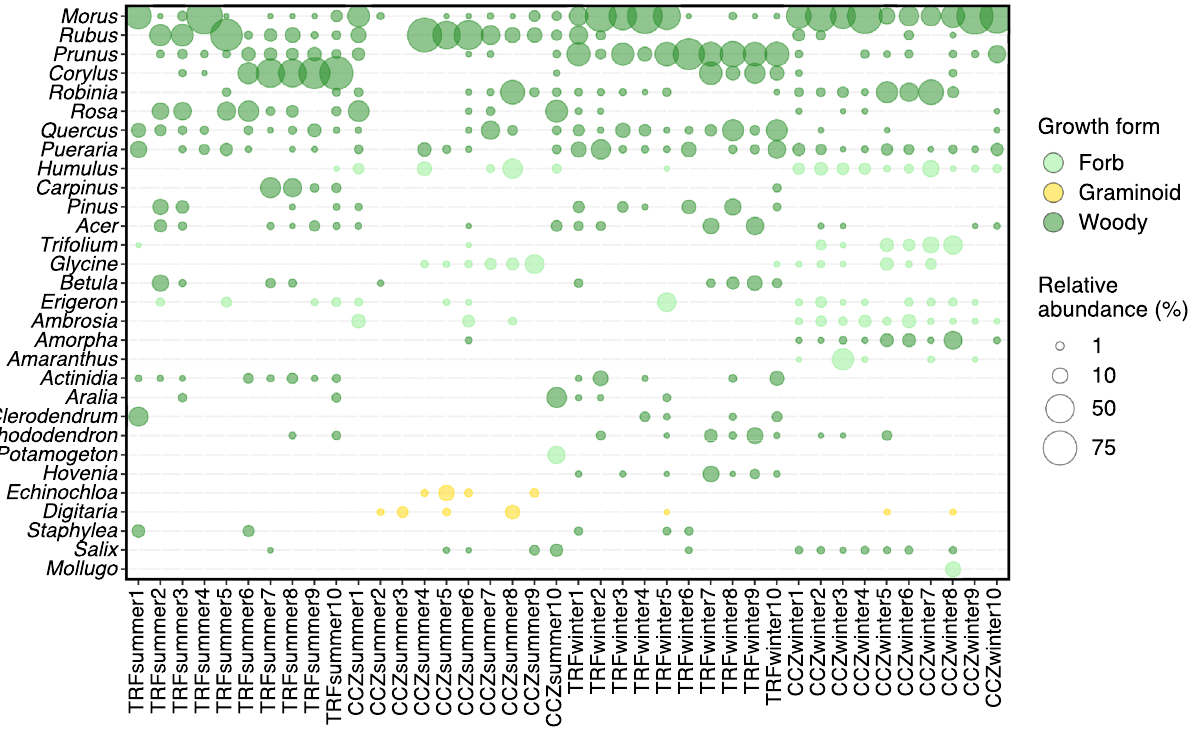
Figure 3. Relative abundance of the 30 most abundant plant genera.